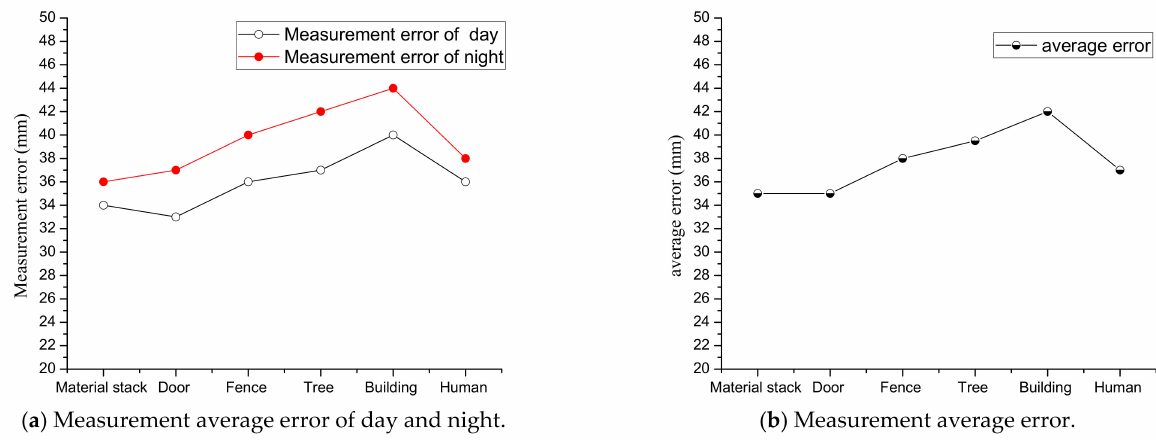
Figure 11. Measurement average